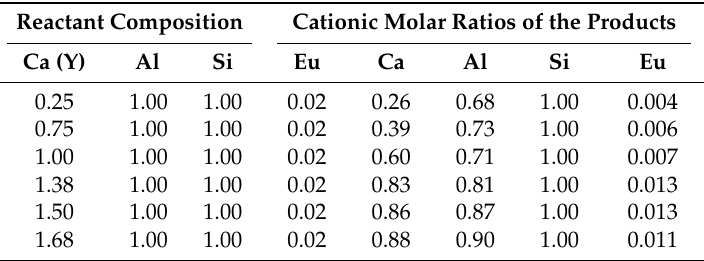
Table 2. SEM-EDS (scanning electron micrographs (SEM) together with energy-dispersed X-ray spectroscopy (EDS)) analysis of cationic molar ratios of the products (synthesized with various Y ) after grinding and washing with an acid (also shown are the reactant